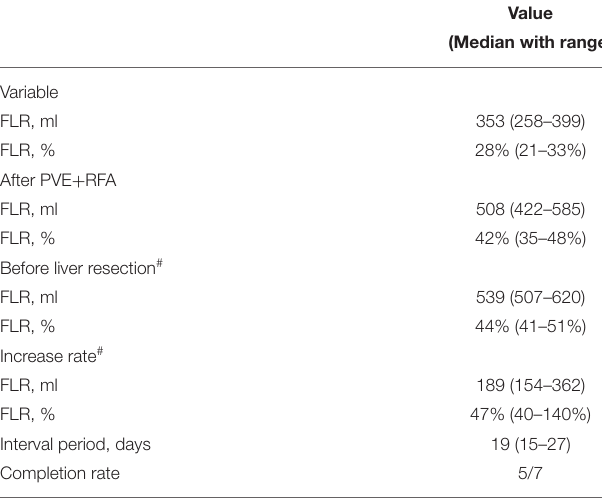
TABLE 3 | FLR changes before and after PVE +